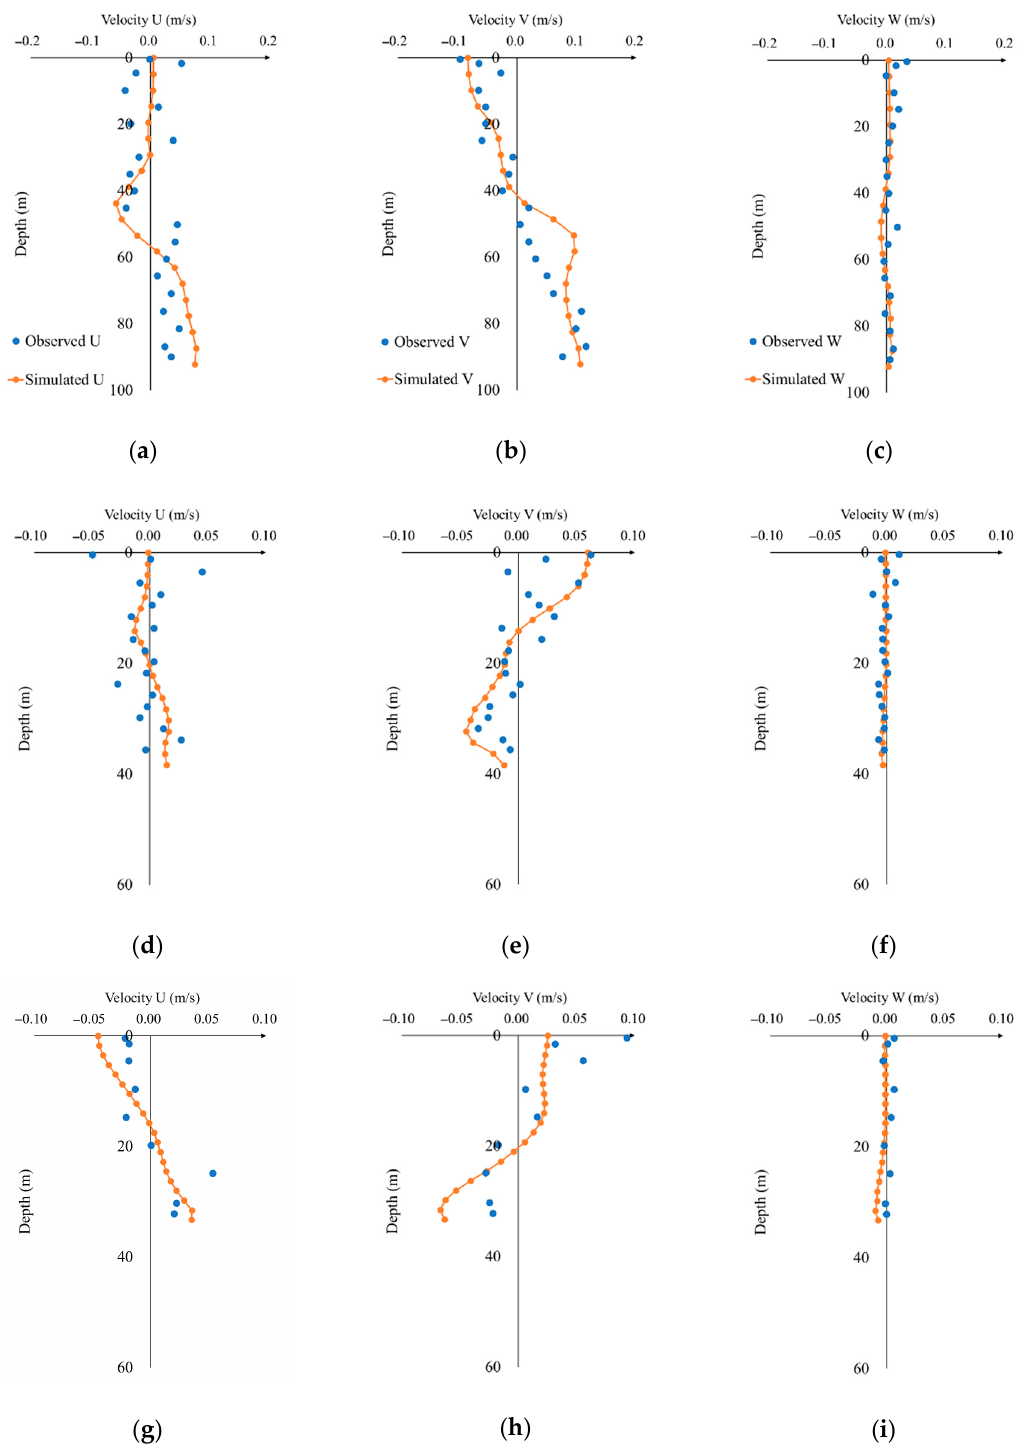
Figure 9. Simulated 3D velocity field versus observed field data by acoustic doppler velocimeter (ADV) along the Xiangxi River. ( a ) Comparison of the velocity component U along the X direction at the downstream measuring site xx#1; ( b ) Comparison of the velocity component V along the Y direction at xx#1; ( c ) Comparison of the velocity component W along the Z direction at xx#1. Similar for the U, V and W velocity components at the middle reach measuring site xx#2 as displayed in ( d – f ), respectively. The U, V and W velocity components at the upper reach measuring site xx#3 are as displayed in ( g – i ), respectively. The legend shown for xx#1 is the same for xx#2 and xx#3.